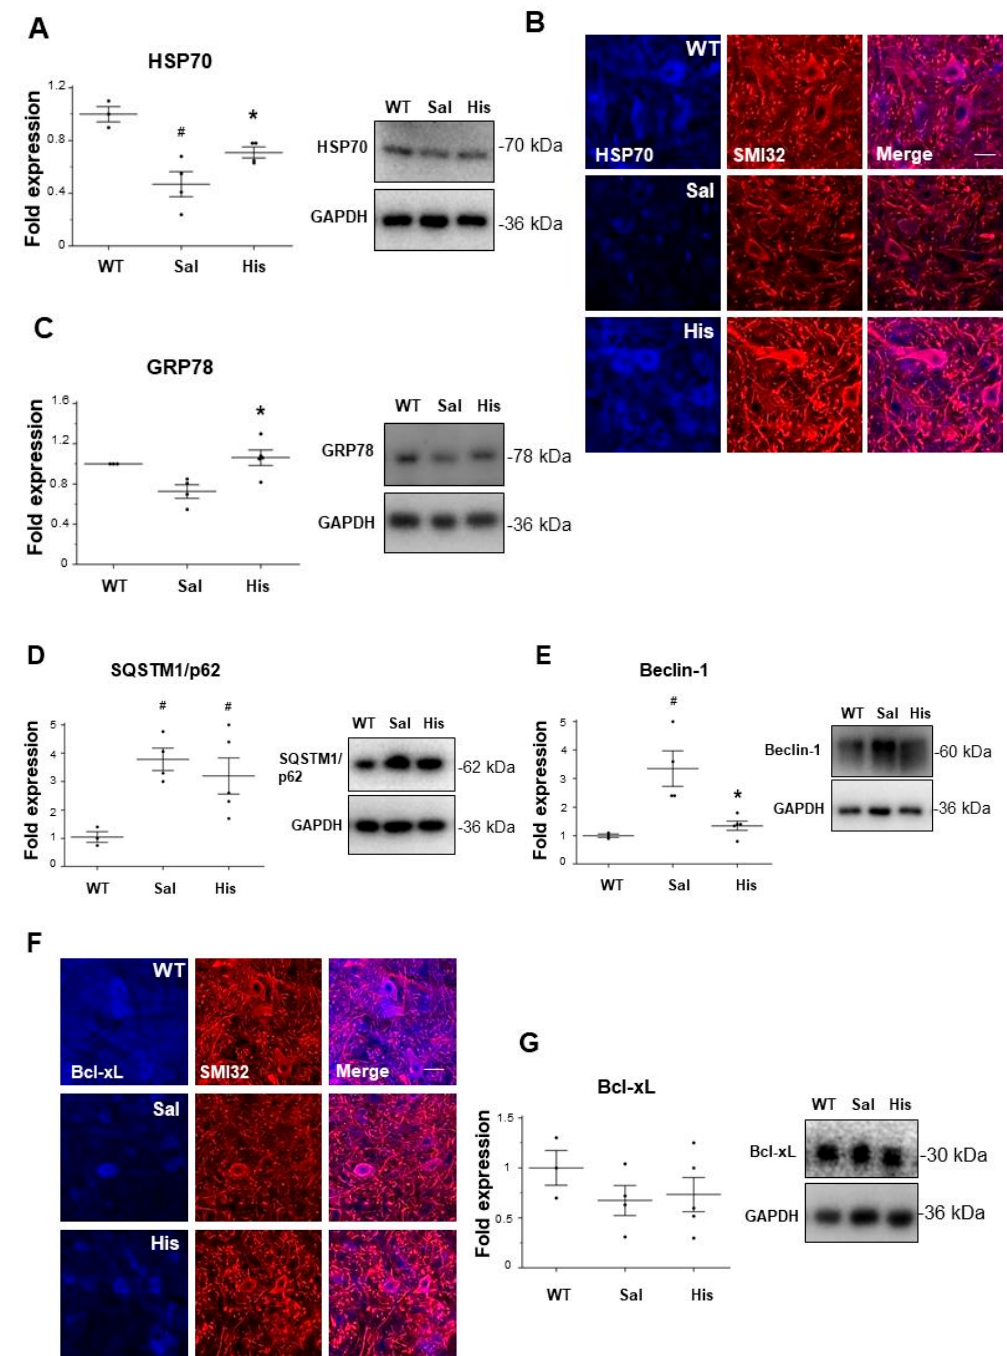
Figure 3. Histidine modulates the expression of Hsp70, GRP78, Beclin-1 and Bcl-xL in the spinal cord of symptomatic SOD1-G93A mice. Representative western blots and quantification of Hsp70 ( A ), GRP78 ( C ), SQSTM1 / p62 ( D ), Beclin-1 ( E ) and Bcl-xL ( G ) in saline ( n = 4) and histidine-treated 100 mg / kg ( n = 5) SOD1-G93A mice. GAPDH was used as a loading control. Data represent mean ± S.E.M. Statistical significance was calculated by ANOVA, as referred to WT, # p < 0.05 or to SOD1-G93A saline-treated mice, * p < 0.05. ( B ) Representative immunofluorescence images of Hsp70 (blue) and SMI32 (red) in saline ( n = 4) and 100 mg / kg histidine-treated ( n = 5) SOD1-G93A mice. Scale bar: 100 µ m. ( F ) Representative immunofluorescence images of Bcl-xL (blue) and SMI32 (red) in saline ( n = 4) and 100 mg / kg histidine-treated ( n = 5) SOD1-G93A mice. Scale bar: 100 µ m.